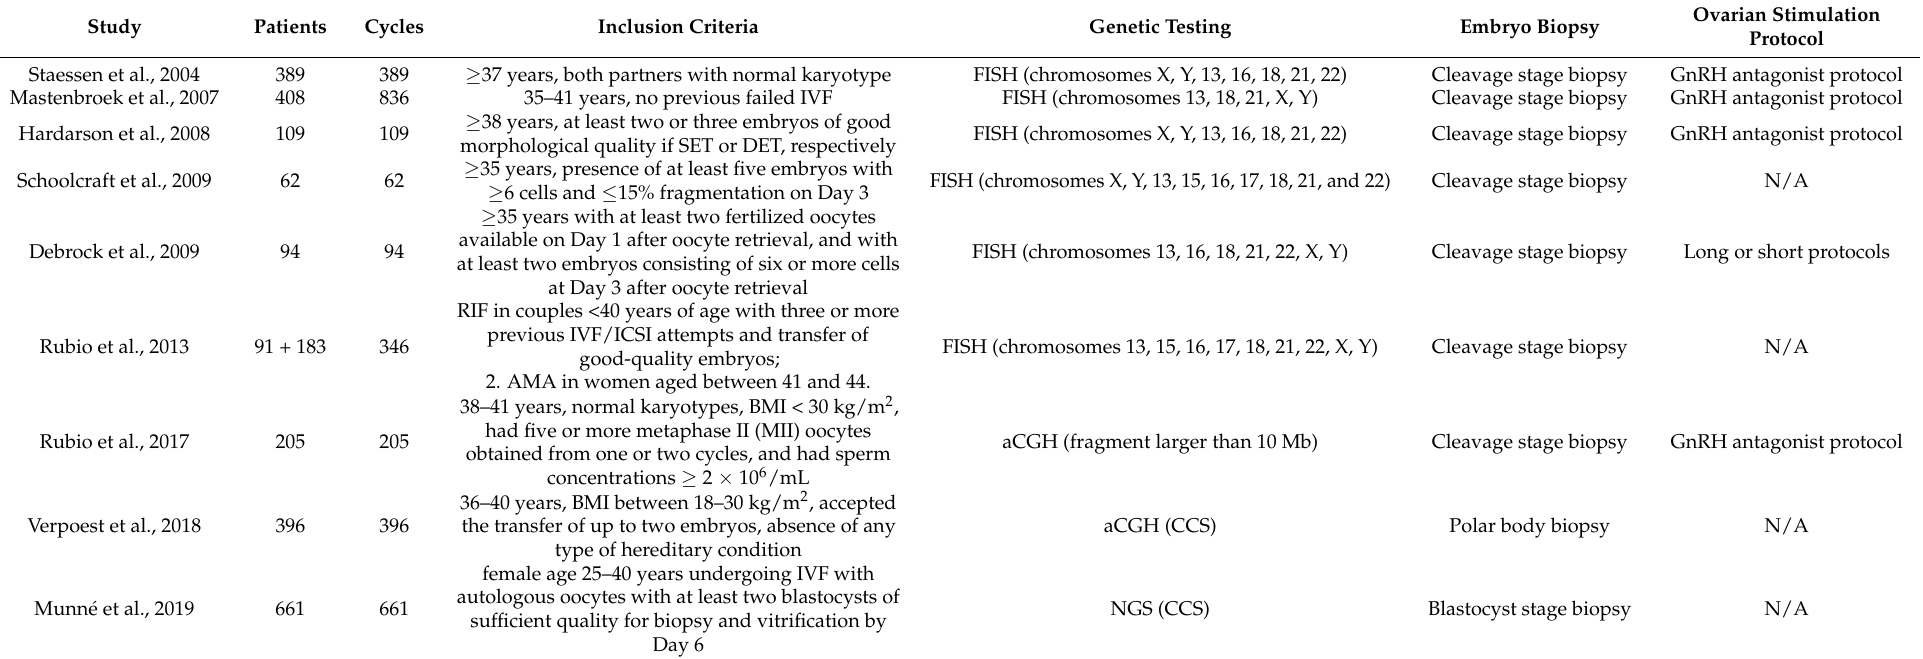
Table 1. Characteristics of included studies involving PGT-A in women of